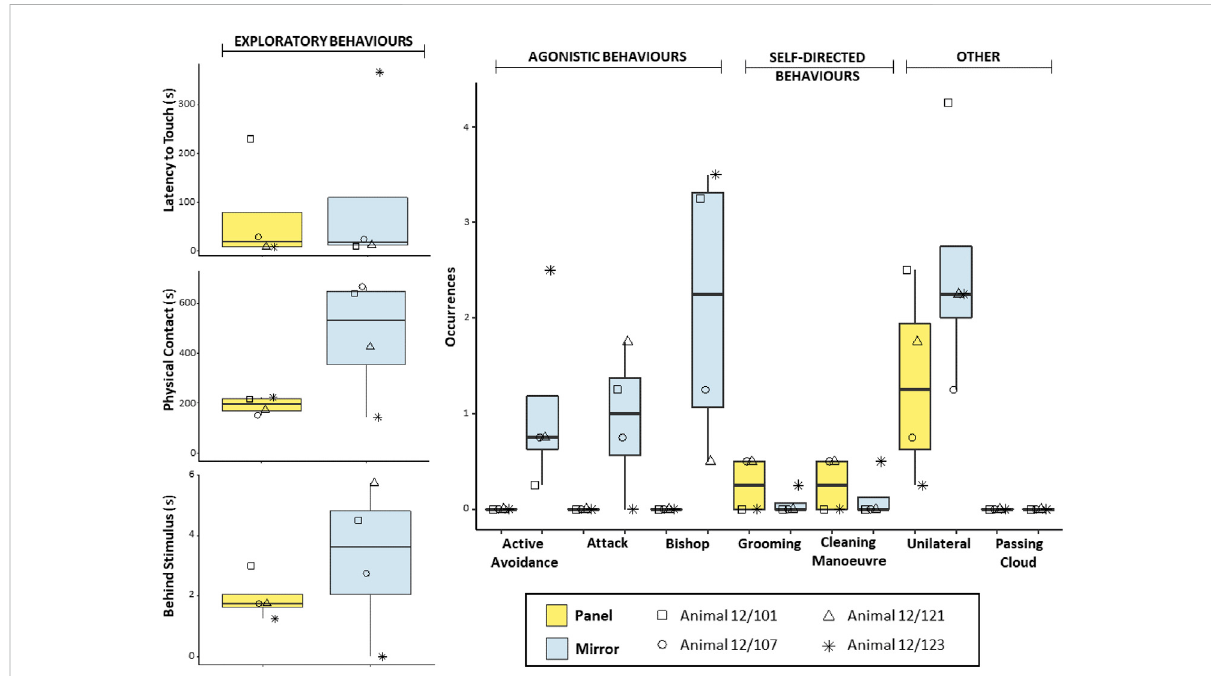
FIGURE 2 Box and whisker plot of the responses of O. vulgaris ( Panel group) to the mirror (light blue) and the non-re fl ective panel (yellow) during the familiarization